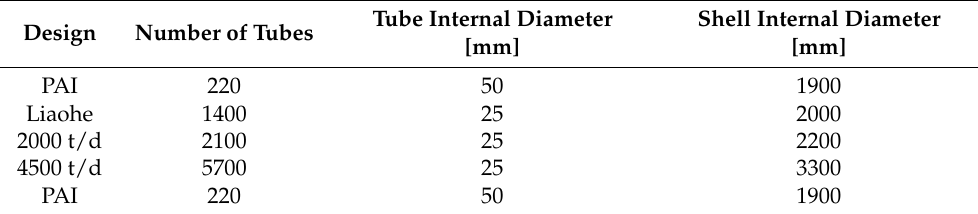
Table 4. Comparison of KRES designs for different